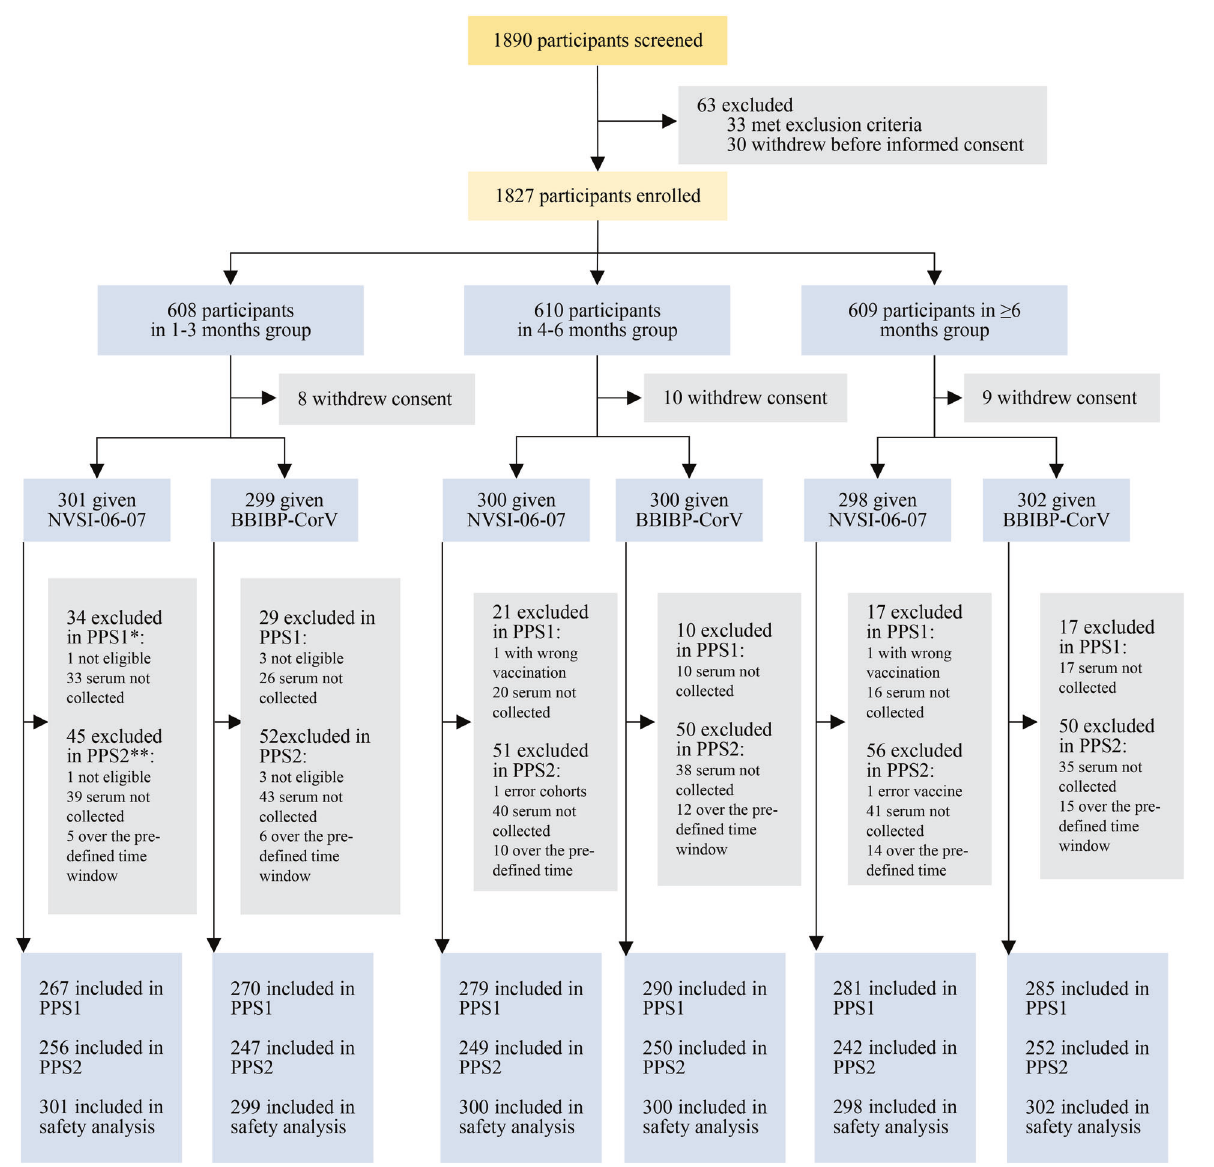
Fig. 1 Trial pro fi le. *PPS1: per-protocol analysis of immunogenicity on day 14 post booster vaccination; **PPS2: per-protocol analysis of immunogenicity on day 28 post booster vaccination; In PPS2, the sera from all the participants were used to evaluate the neutralizing antibody titers, and 255 participants in the 1 – 3 months group receiving NVSI-06-07 boost, 241 in the ≥ 6 months group receiving NVSI-06-07 and 251 in the ≥ 6 months group receiving BBIBP-CorV were used to detect the RBD-binging IgG